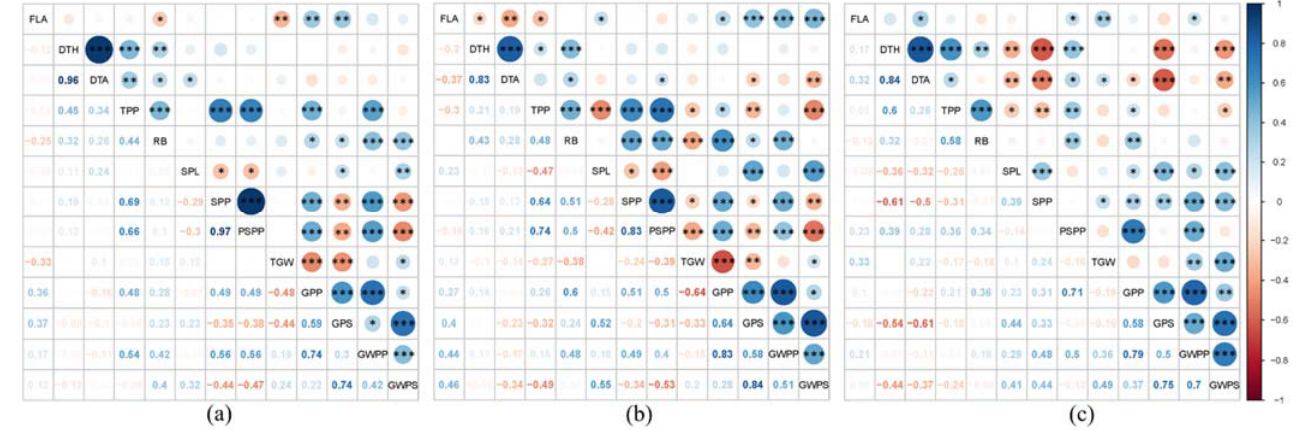
Figure 4. Correlation among morphological, phenological and yield traits flag ‐ leaf area (FLA), days to heading (DTH), days to anthesis (DTA), tillers per plant (TPP), root biomass (RB), spike length (SPL), spikes per plant (SPP), productive spikes per plant (PSPP), 1,000 ‐ grain weight (TGW), grains per plant (GPP), grains per spike (GPS), grain weight per plant (GWPP), grain weight per spike (GWPS) studied in wheat under ( a ) control (C), ( b ) early drought stress (EDS) and ( c ) late drought stress (LDS). ***: sig. < 0.001, **: sig. < 0.01, *: sig. < 0.05